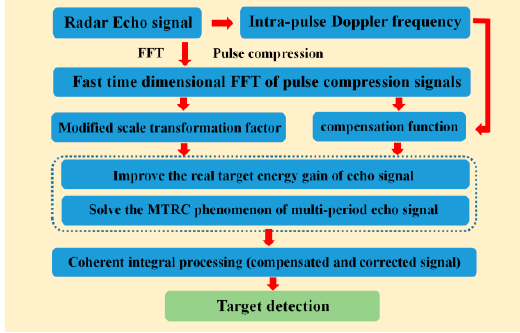
Figure 5. The flowchart of improved the Keystone algorithm.